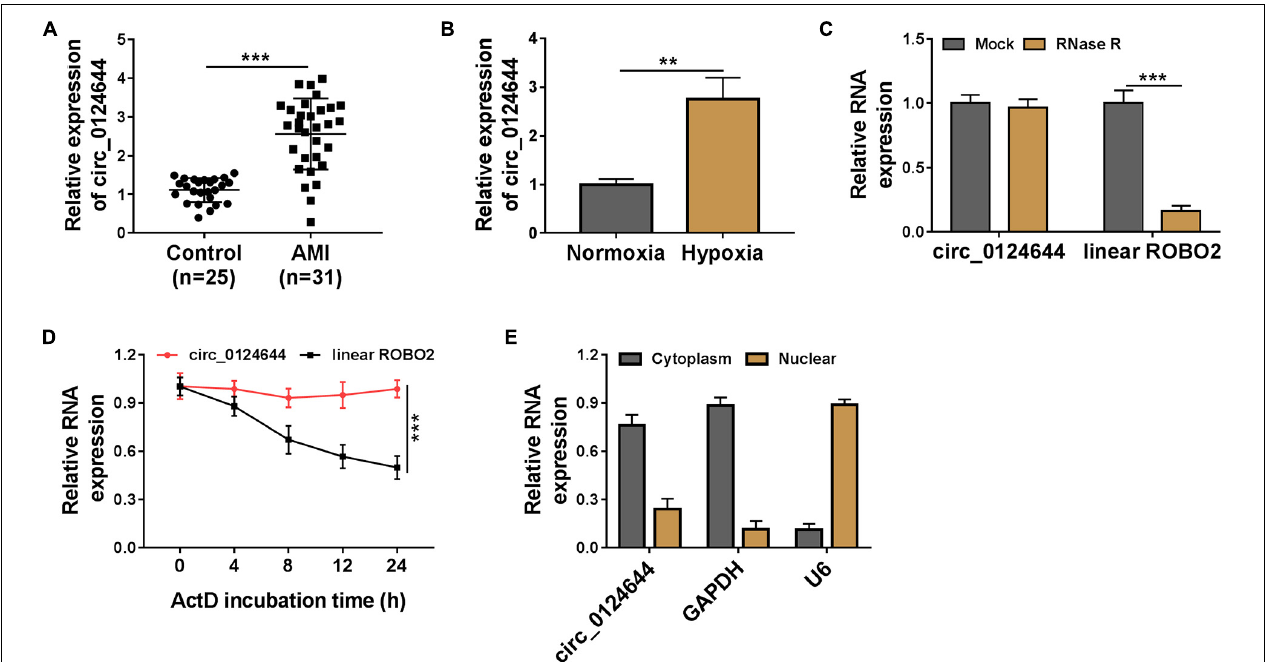
FIGURE 1 | The expression of circ_0124644 in AMI patients and hypoxia-induced AC16 cells. (A) The circ_0124644 expression in the serum of AMI patients and healthy control volunteers was measured using qRT-PCR. (B) The expression of circ_0124644 was detected using qRT-PCR in hypoxia-treated and normoxia-treated AC16 cells. RNase R assay (C) and Act D assay (D) were used to confirm the stability of circ_0124644. (E) Subcellular localization analysis was performed to assess the distribution of circ_0124644 in the cytoplasm and nuclear of AC16 cells. ** P < 0.01, *** P <